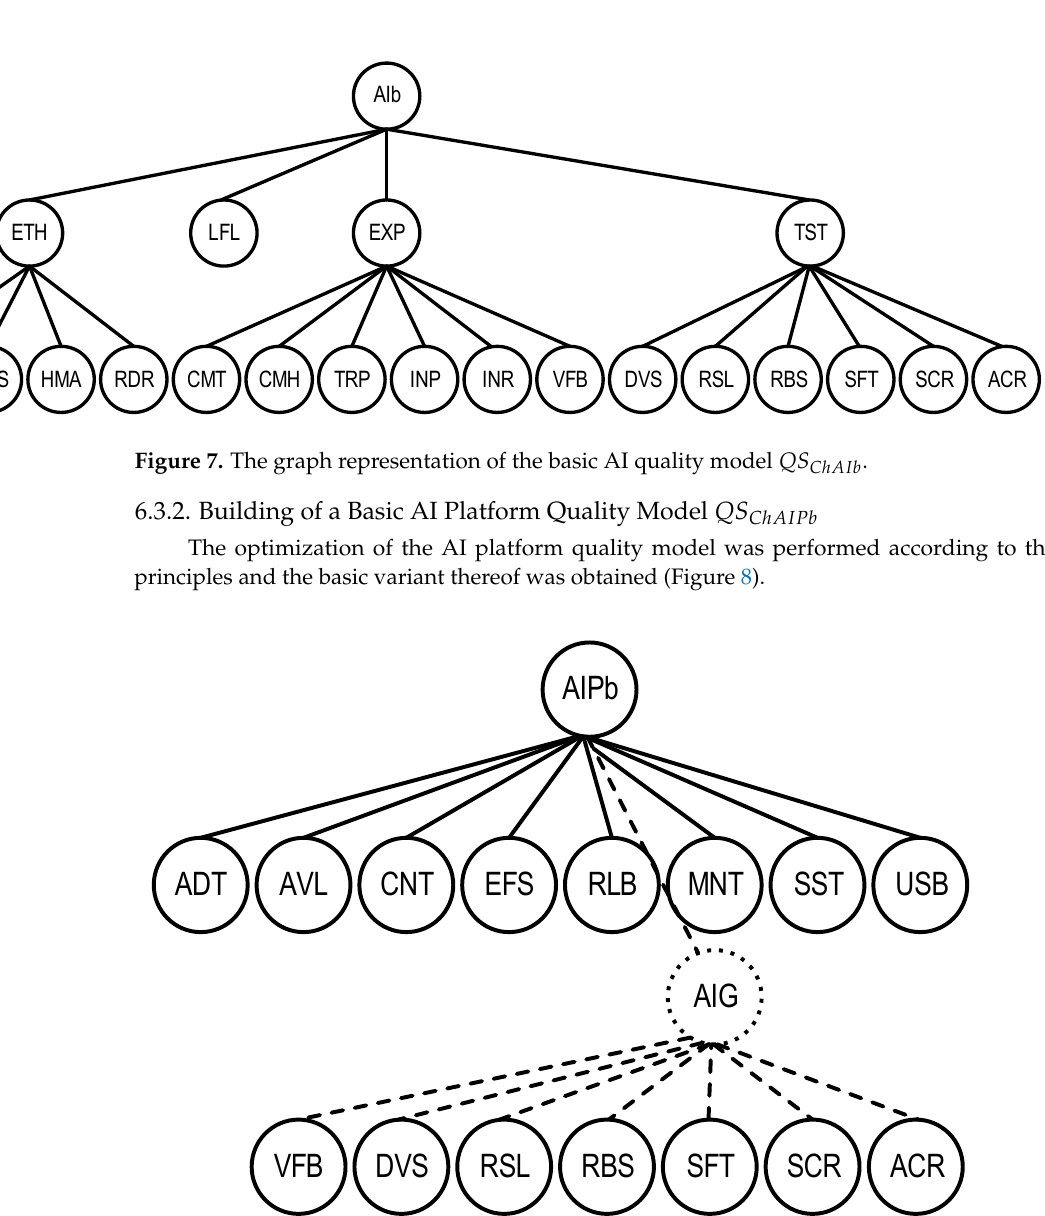
. Figure 8. The graph representation of the basic AI platform quality model QS ChAIPb 𝐶ℎ𝐴𝐼𝑃𝑏